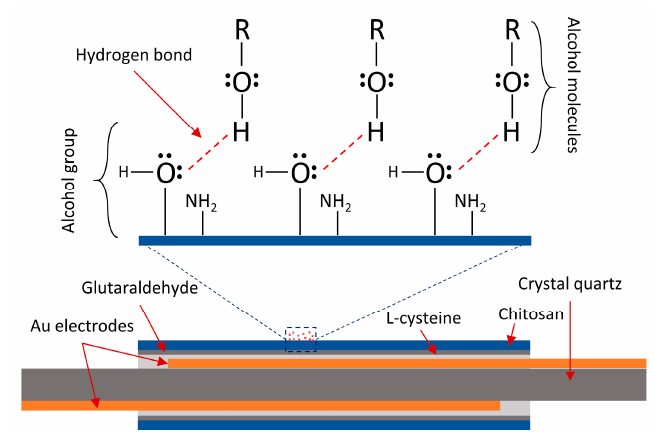
Figure 8. Schematic of the interaction mechanism between alcohol and chitosan layer.